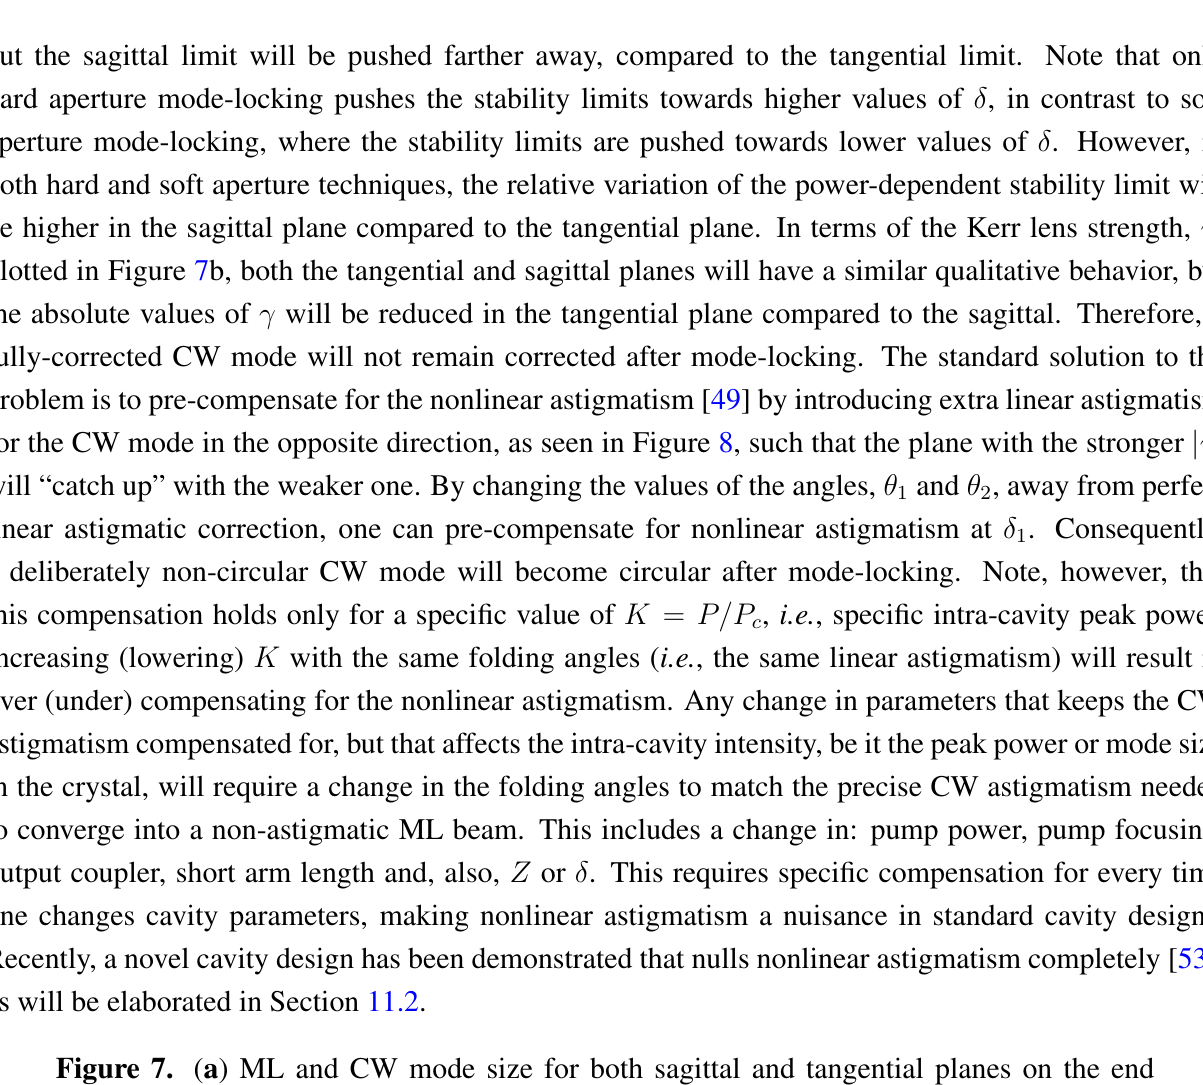
, for hard aperture mode-locking; 1